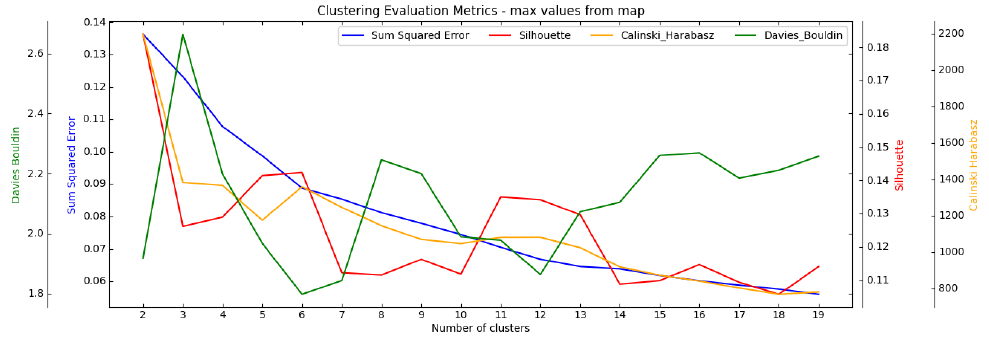
Figure 6. Clustering evaluation metrics for maximum values for gridded data.